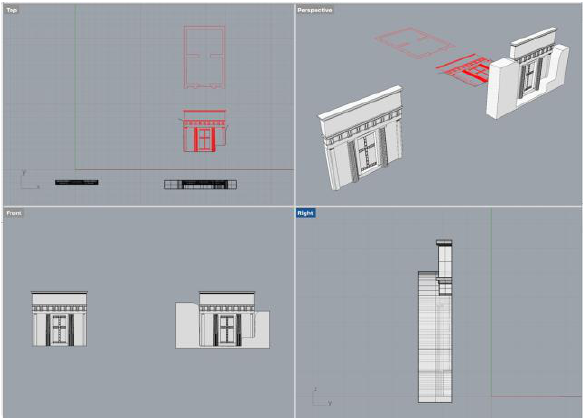
Figure 21. The Tomb of Philip II in Verghina. Construction of the 3D model.